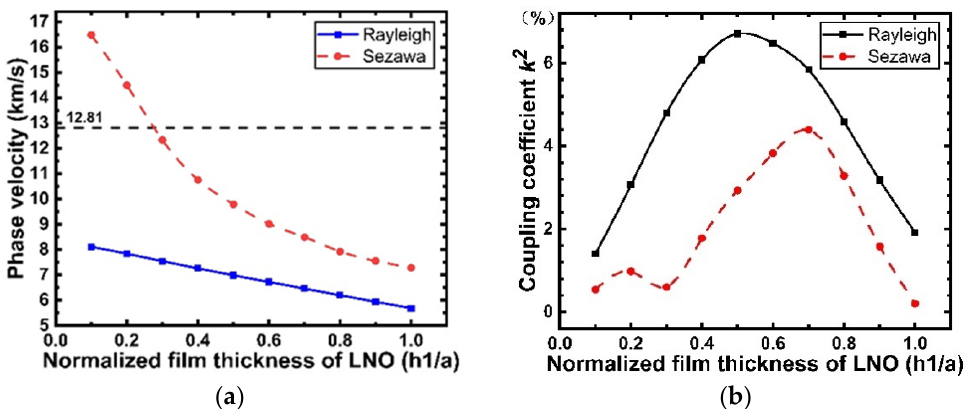
Figure 10. ( a ) SAW velocity versus normalized thickness of LiNbO 3 in SiO 2 -free structure; ( b ) Electromechanical coupling coefficient versus normalized LiNbO 3 thickness in SiO 2 -free structure.